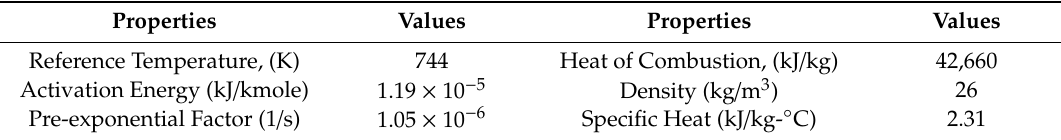
Table 3. Thermal properties of the polyethylene foam (PE) test sample.